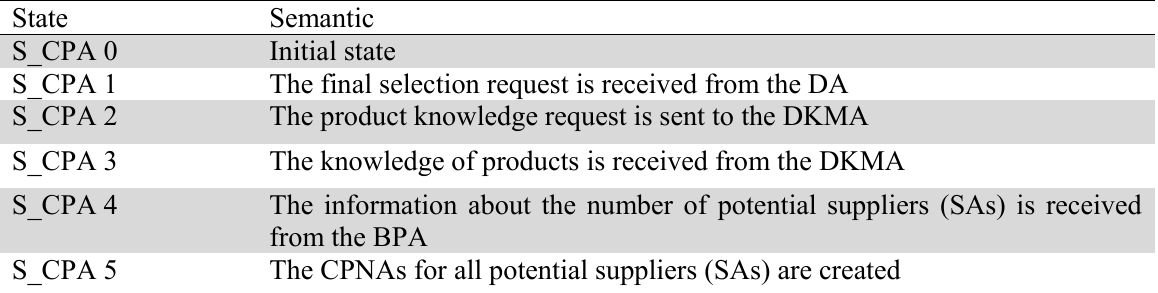
Fig. 5. State transition diagram of the BPA The CPA’s states and their